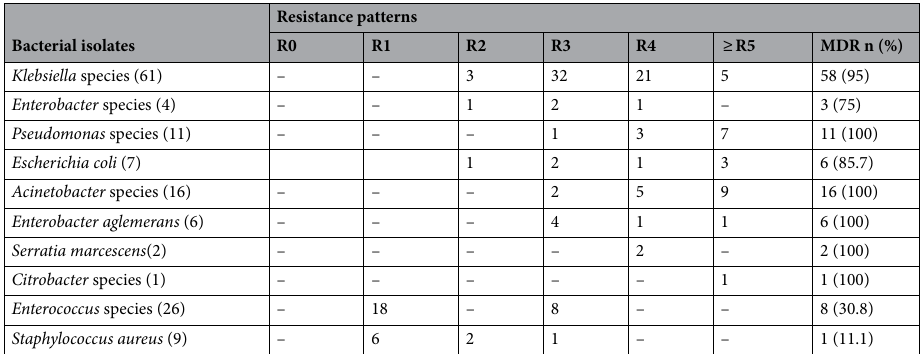
Table 7. Multidrug resistance profile of bacteria isolated from blood culture of newborns suspected of sepsis at Hawassa University Comprehensive Specialized Hospital from February 2021 to November 2021. NICU Neonatal intensive care unit, HUCSH Hawassa comprehensive specialized hospital, MDR Multiple drug resistance (resistance to three or more drugs categories), R0 No resistance at all, R1 resistant to one antimicrobial class, R2 resistant to two antimicrobials class, R3 Resistant to three antimicrobials class, R4 resistant to four antimicrobials class, R5 resistant to five or more antimicrobials